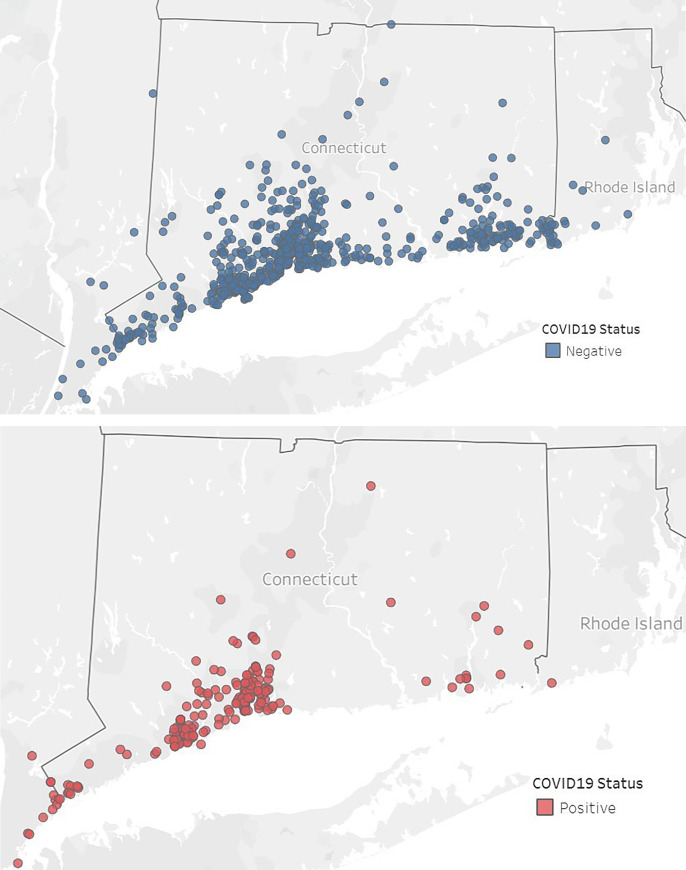
(a). Geospatial mapping of heart failure patients who tested negative for COVID-19. Dots represent individual patient home addresses. (b). Geospatial mapping of heart failure patients who tested positive for COVID-19. Dots represent individual patient home addresses.